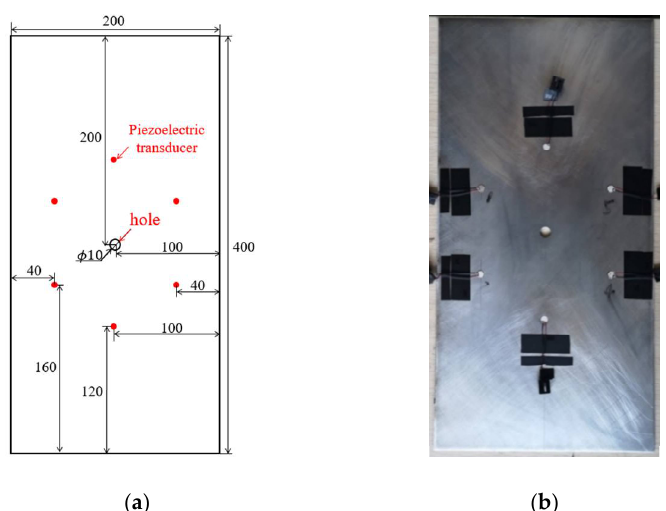
Figure 7. The sensors network design of testing specimen ( a ) diagram (mm) ( b ) the real layout. Metals 2020 , 10 , x FOR PEER REVIEW